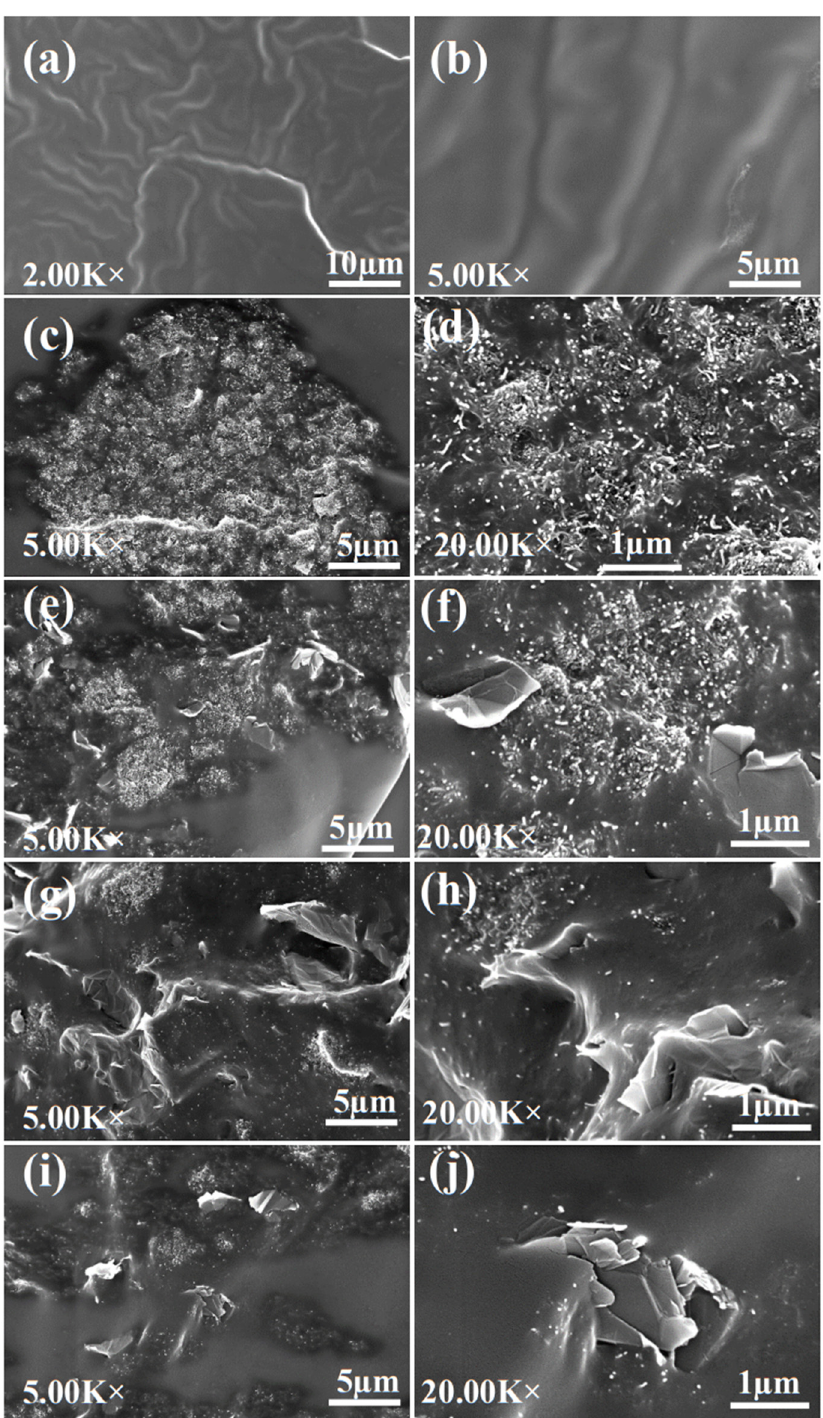
Figure 4. FESEM images of the cross section in thickness direction of PU and modified PU conductive films with different GN and CNT: ( a , b ) PU; ( c , d ) CNT 0.2 /PU; ( e , f ) G1 0.1 -CNT 0.2 /PU; ( g , h ) G2 0.1 -CNT 0.2 /PU; ( i , j ) rGO 0.1 -CNT 0.2 /PU.